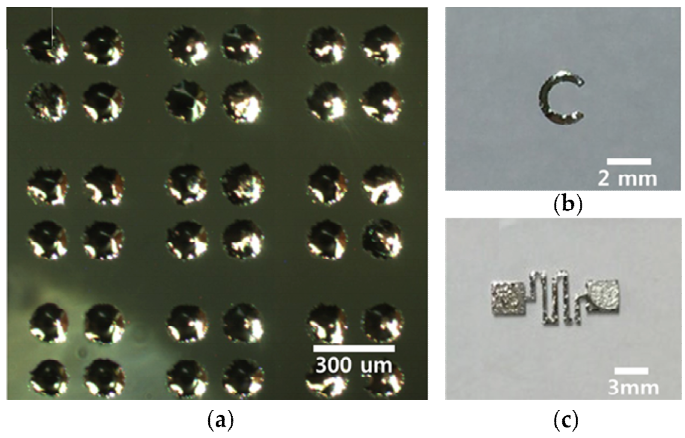
Figure 8. ( a ) Optical image of 150-µm holes LM pattern by spray printing with polymeric membrane mask. Other patterns have been fabricated, ( b ) a letter “C” and ( c ) a short electrode line.